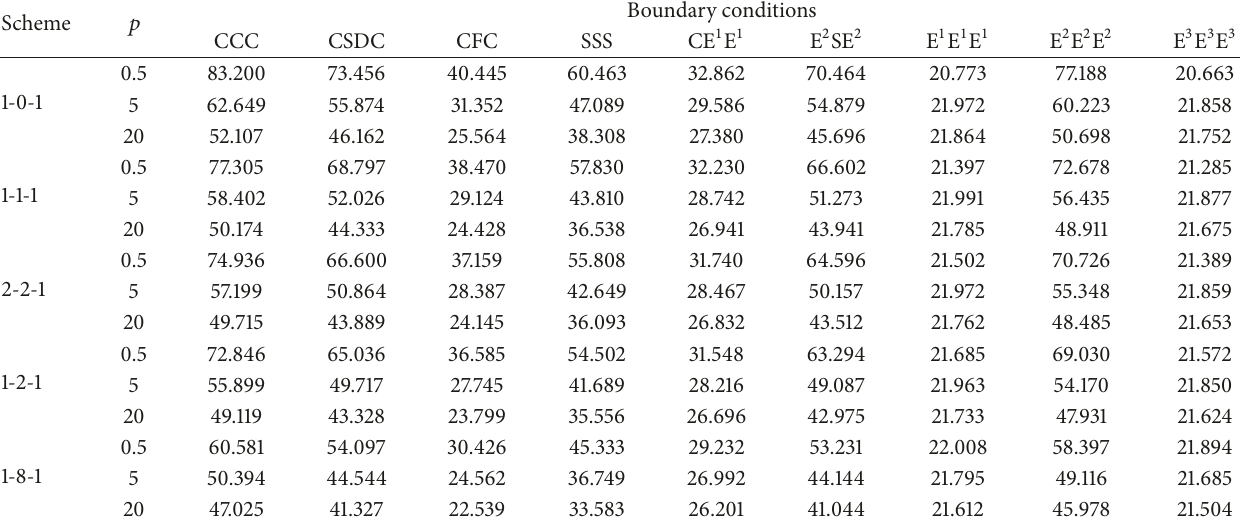
Table 10: Fundamental frequency parameter Ω for Type 1-2 circular sector plate with various boundary conditions ( ℎ/𝑅 1 = 0.2, 𝑝 2 = 𝑝 , and 𝜙 = 60 ∘